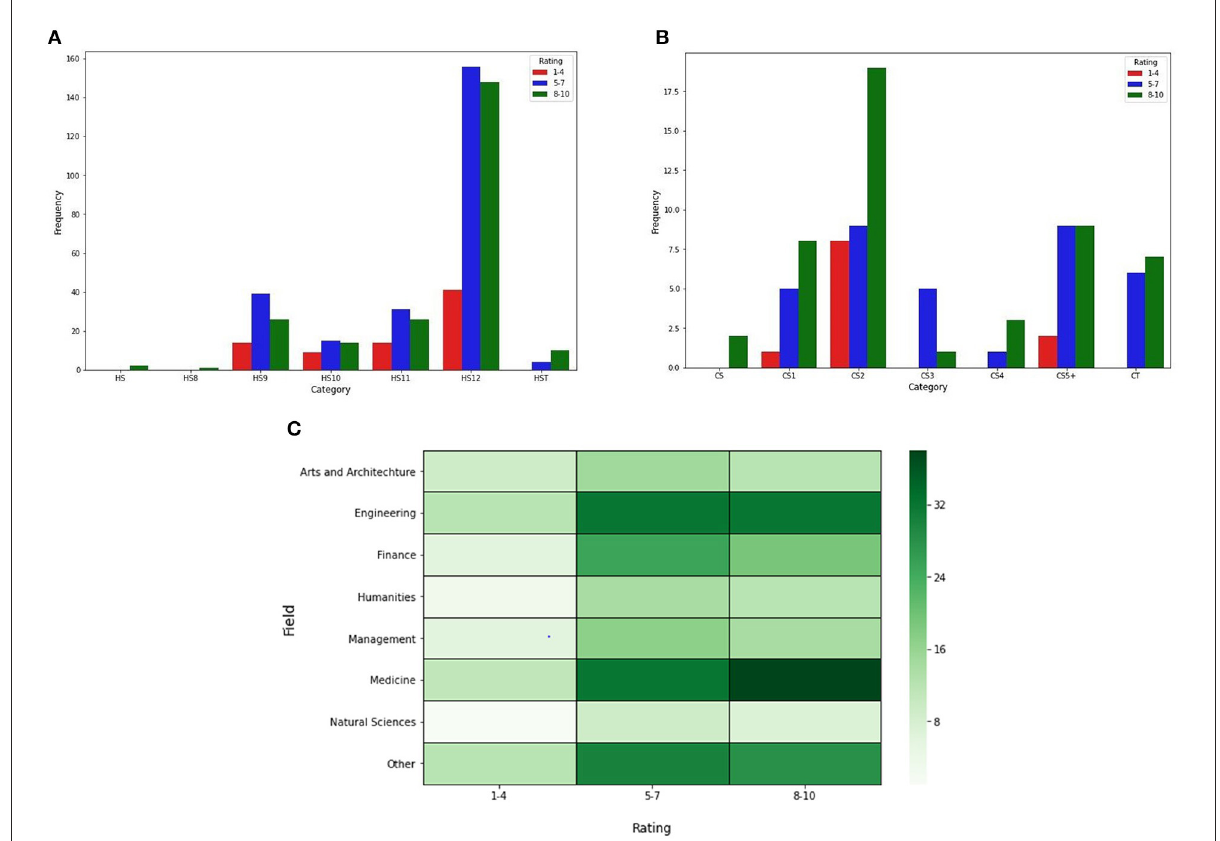
FIGURE3 Awareness of vaccine development. (A, B) Bar graphs comparing the class level of high school (HS) students (B) year of college students (college) based on their education and rating of awareness of vaccine development. The bars correspond to the respondents’ understanding of vaccine development on a scale of 1–10; by overall ranges. (C) Heat maps comparing the subject of interest of the individual with the rating of awareness of vaccine